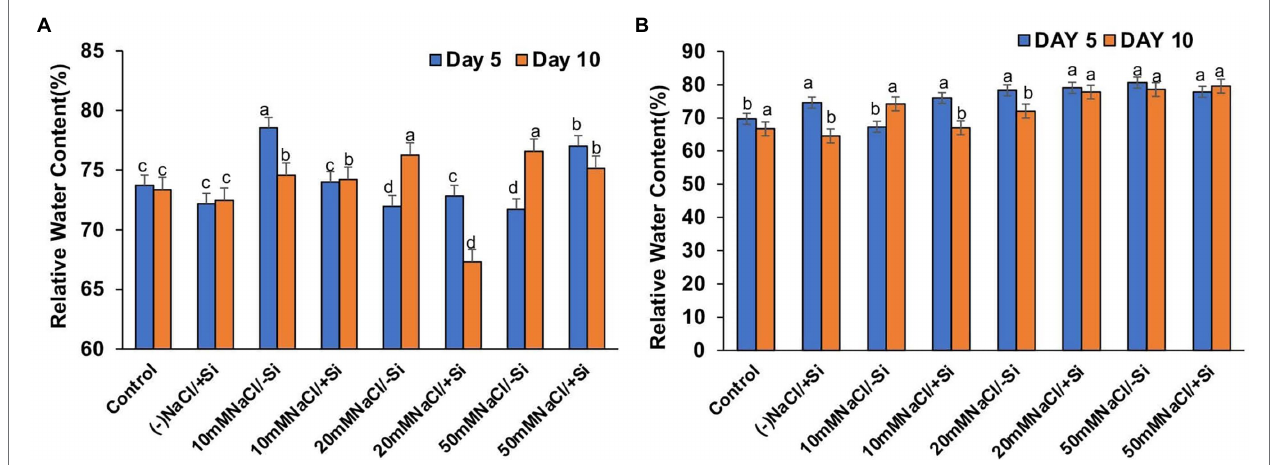
FIGURE 8 | Changes in relative water content of mung bean ( Vigna radiata ) under (A) 1 mM (Si 1 ), (B) 5 mM (Si 2 ) Si supply and salinity stress after eight treatments: (i) control (T1), (ii) − NaCl+Si (1 mM/5 mM) (T2), (iii) 10 mM NaCl/ − Si (T3), (iv) 10 mM NaCl/+Si (1 mM/5 mM) (T4), (v) 20 mM NaCl/ − Si (T5), (vi) 20 mM NaCl/+Si (1 mM/5 mM) (T6), (vii) 50 mM NaCl/ − Si (T7), and (viii) 50 mM NaCl/+Si (1 mM/5 mM) (T8) for a period of 5 and 10 days. Vertical bars indicate Mean ± SE of the means for n = 4. Means denoted by the different letters are significantly different at p ≤ 0.05 according to the Tukey’s studentized range